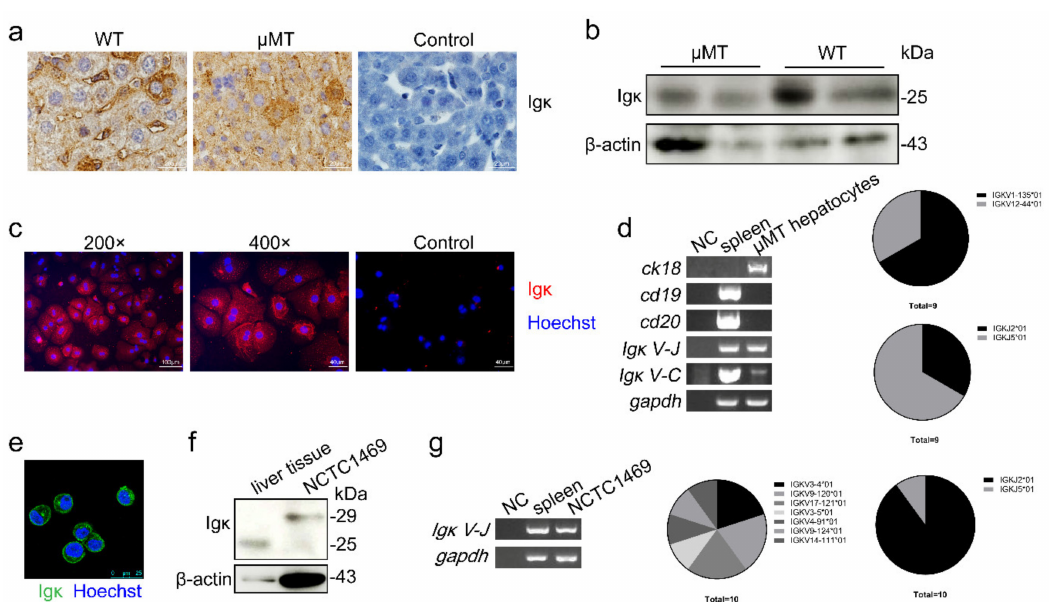
Figure 1. Expression of Ig κ in mouse primary hepatocytes and a normal hepatocyte cell line. ( a ) Immunohistochemistry and ( b ) Western blot analysis of Ig κ in wild type (WT) and µ MT mouse liver tissue. Control indicates isotype control. ( c ) The magnification and immunofluorescence analysis of Ig κ in primary hepatocytes in µ MT mice. Rabbit IgG as isotype control. ( d ) Reverse-transcription